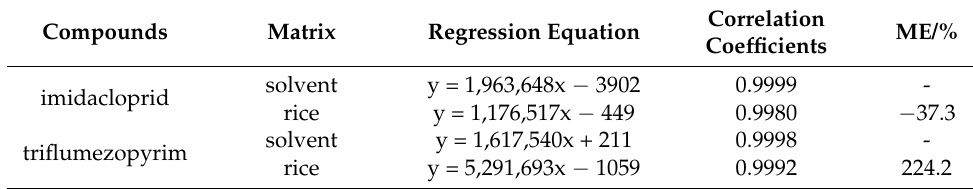
Table 2. Method validation parameters.